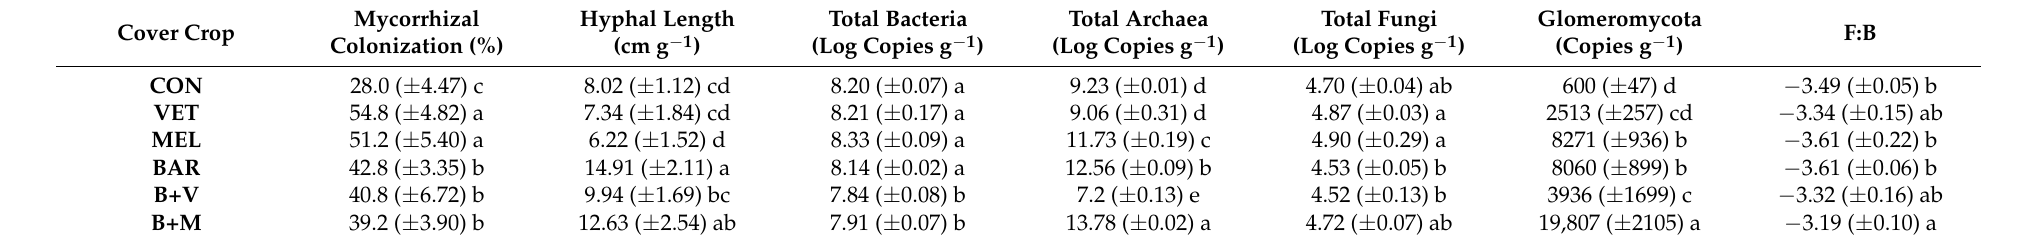
Table 1. Microbial variables in wheat crop after the different cover crops.